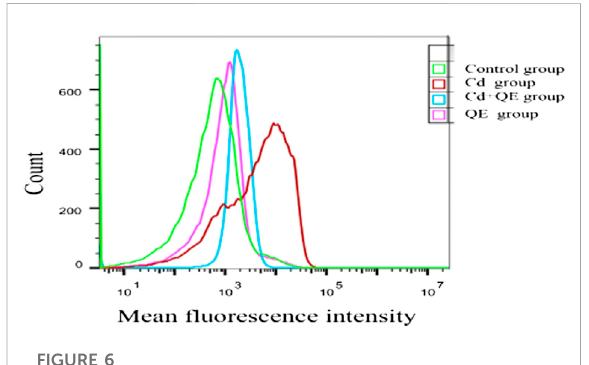
FIGURE 6 Effects of QE on ROS level in Cd-induced BRL-3A cells.